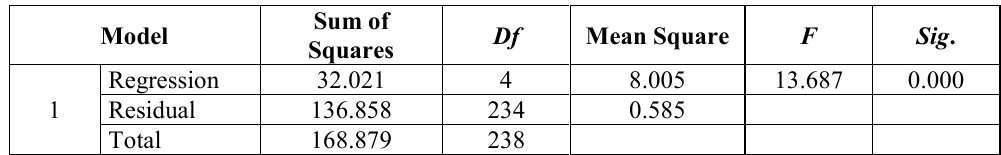
Table 8. Variance Analysis –